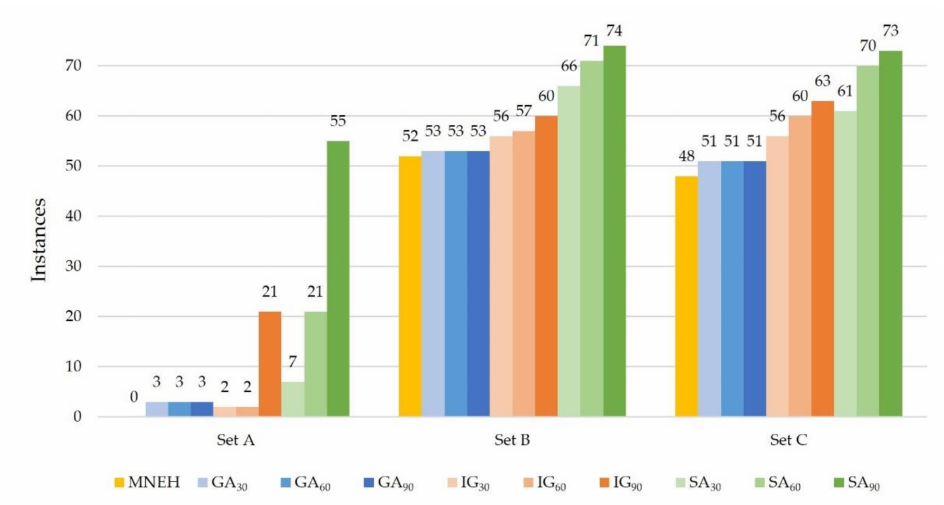
Figure 13. Number of instances that the heuristic found the best solution.